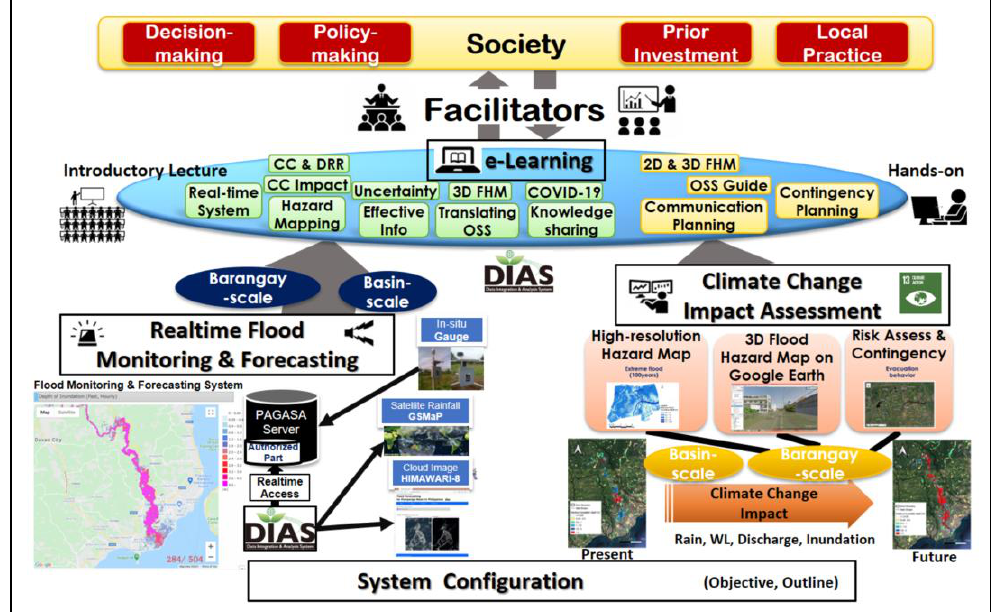
Figure 3. Concept design of the Online Synthesis System for Sustainability and Resilience (OSS-SR) and the Facilitator fostering for Davao City in the